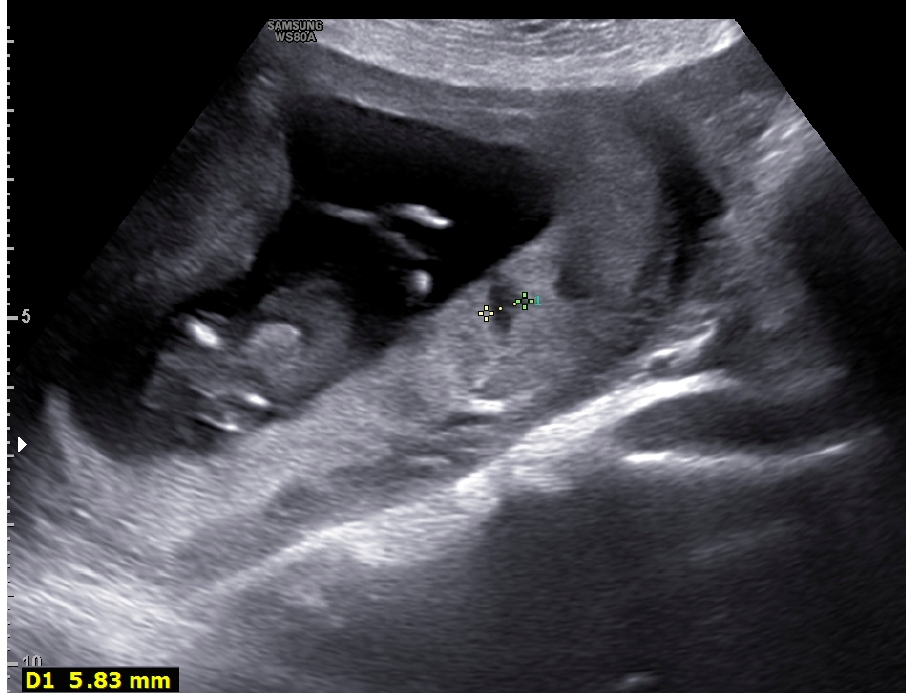
Figure 2. Ultrasonographic placental image of a twelve-week pregnancy: blood pools (max diameter 5.8 mm) are observed.